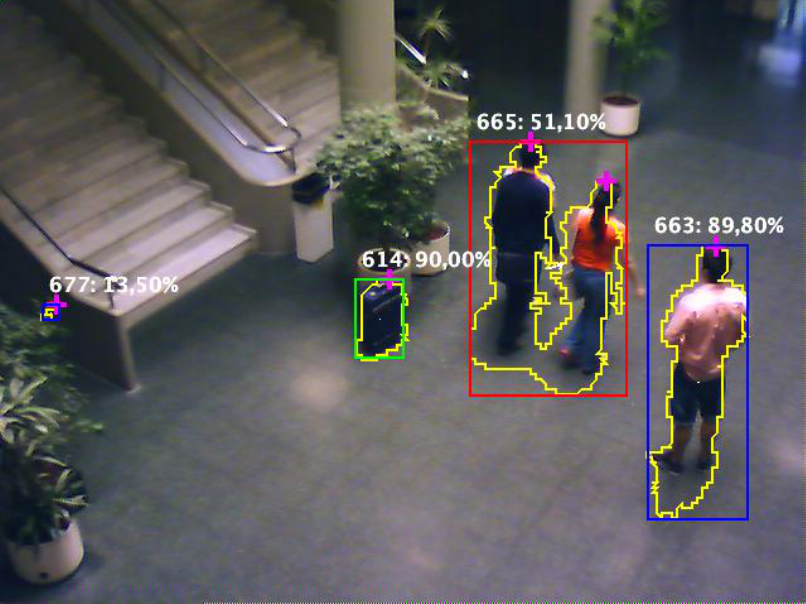
Figure 5. Image obtained from a client application showing the image as well as other information provided by the low level video processing services. The objects are identified with a label, followed by the membership probability. The membership is coded with the color of the bounding boxes (green: Luggage, red: Group, blue: Person). Contours of the objects are also painted, as well as heads, which are depicted by red